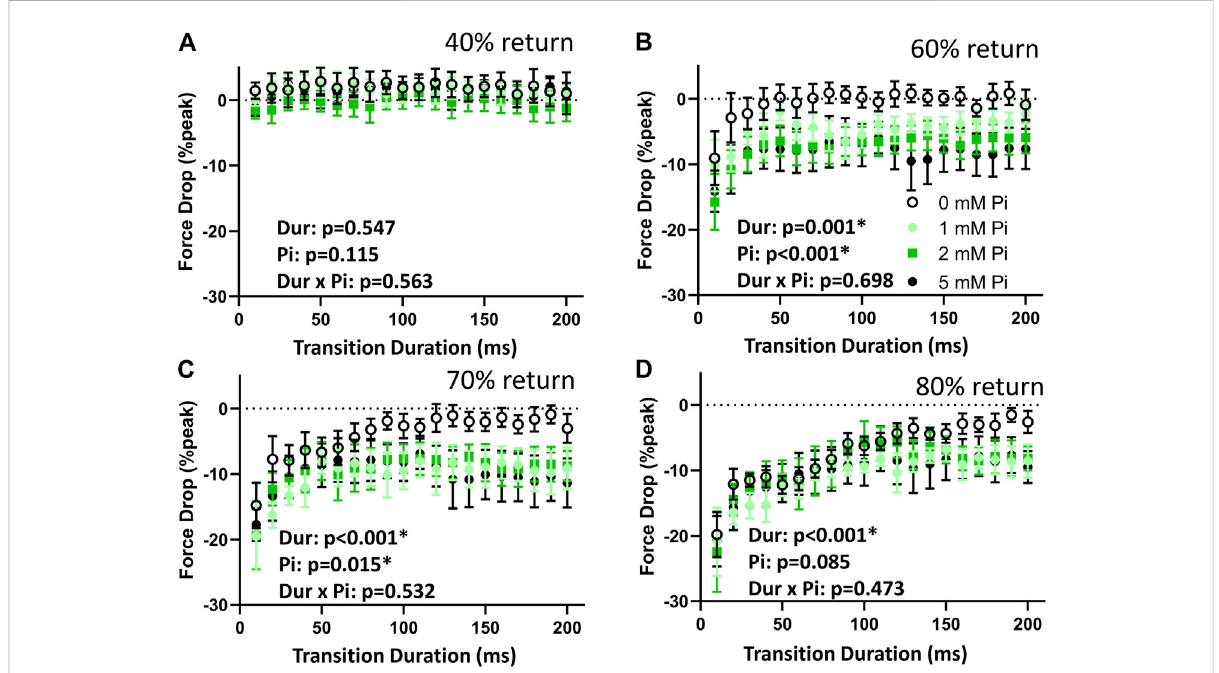
FIGURE 5 Effects of stretch on force drop. (A) The force drop at the 40% return time point was not affected by the lengthening protocol at any Pi concentration. The stimulated transients were therefore not affected by lengthening by this measure. (B) When no extracellular Pi (0 mM Pi) was available, the drop in force at 60% return timepoint was signi fi cant with the 10 ms stretch but was not signi fi cant for the more prolonged stretches. This dependence on duration (Dur) was highly signi fi cant. The drop in force at the 60% return timepoint was signi fi cantly enhanced by Pi. (C) With no extracellular Pi, force drop at the 70% return timepoint was signi fi cant for stretches of 80 ms duration or shorter. Force drop was signi fi cant at all stretch durations when extracellular Pi was available. (D) Force drop at the 80% return timepoint was signi fi cant for stretches of 170 ms or shorter and for all durations when extracellular Pi was